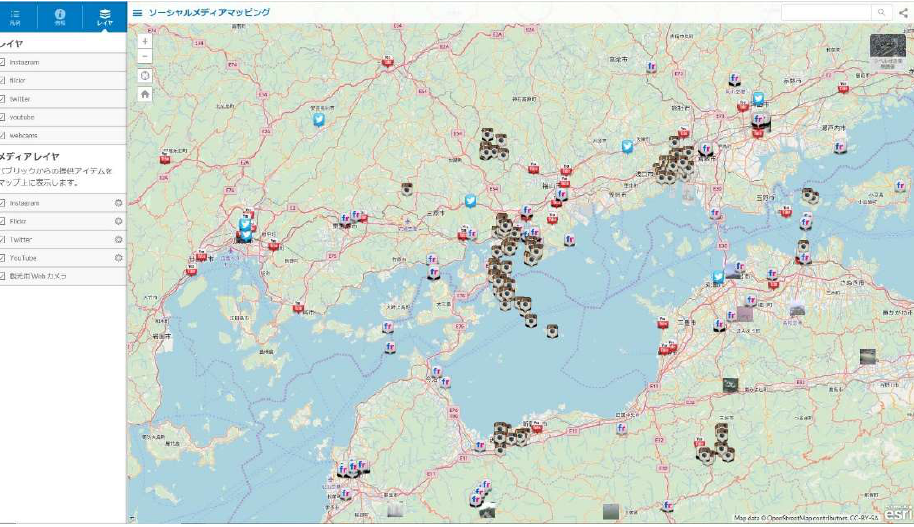
Fig. 3. Screen for the function of social media mapping at the time of the Heavy Rain Disaster in Western Japan in 2018, targeting Setouchi Region.